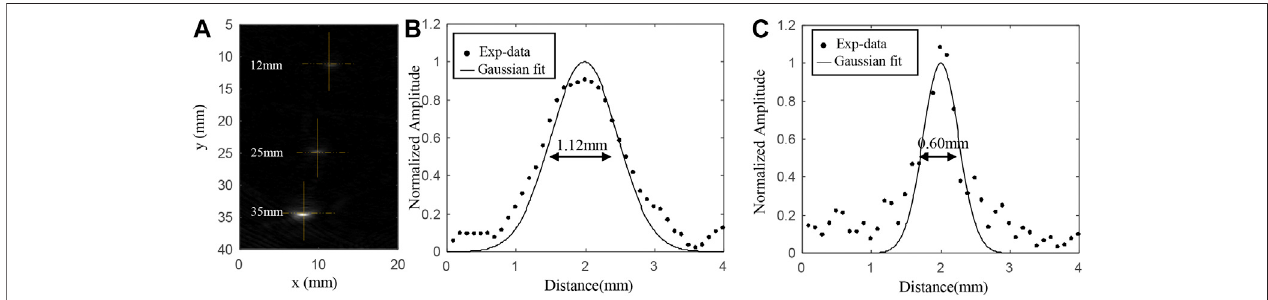
FIGURE4|(A) Schematicdiagramofthesimulationmodelandtheilluminationsetup. (B) Mapoftheoptical fl uencealongtheverticalsectionmarkedbytheyellow plane. (C) Map of the optical fl uence at the horizontal section marked by the white dashed line.